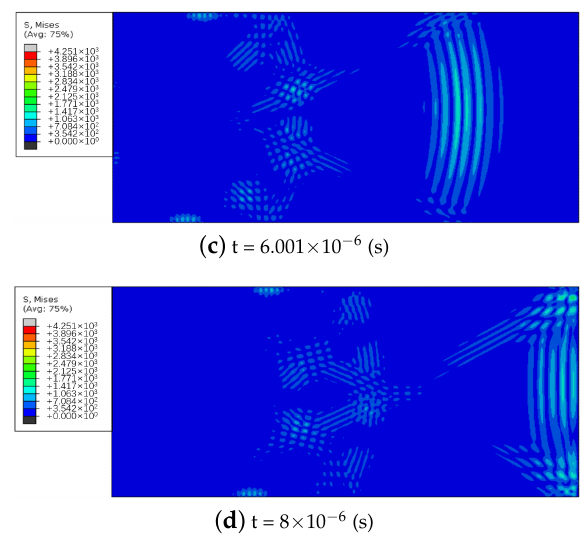
Figure 13. Stress nephogram at different times during ultrasonic propagation.